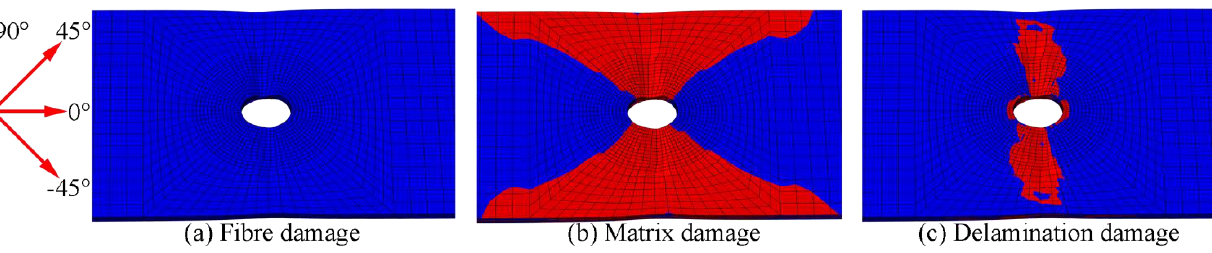
Figure 7. Deformation and damage distribution at the specimen in the final failure state with the fibre orientation